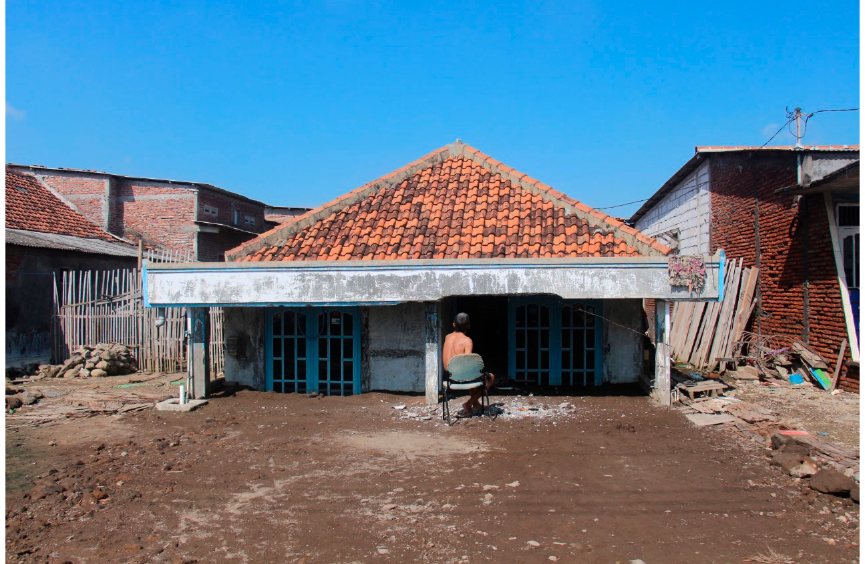
Figure 6. Houses with a very low roof. The landowner performs landfilling to avoid inundation, but is unable to heighten their house. Consequently, half of the house is stockpiled by the materials. Source: field data collection.